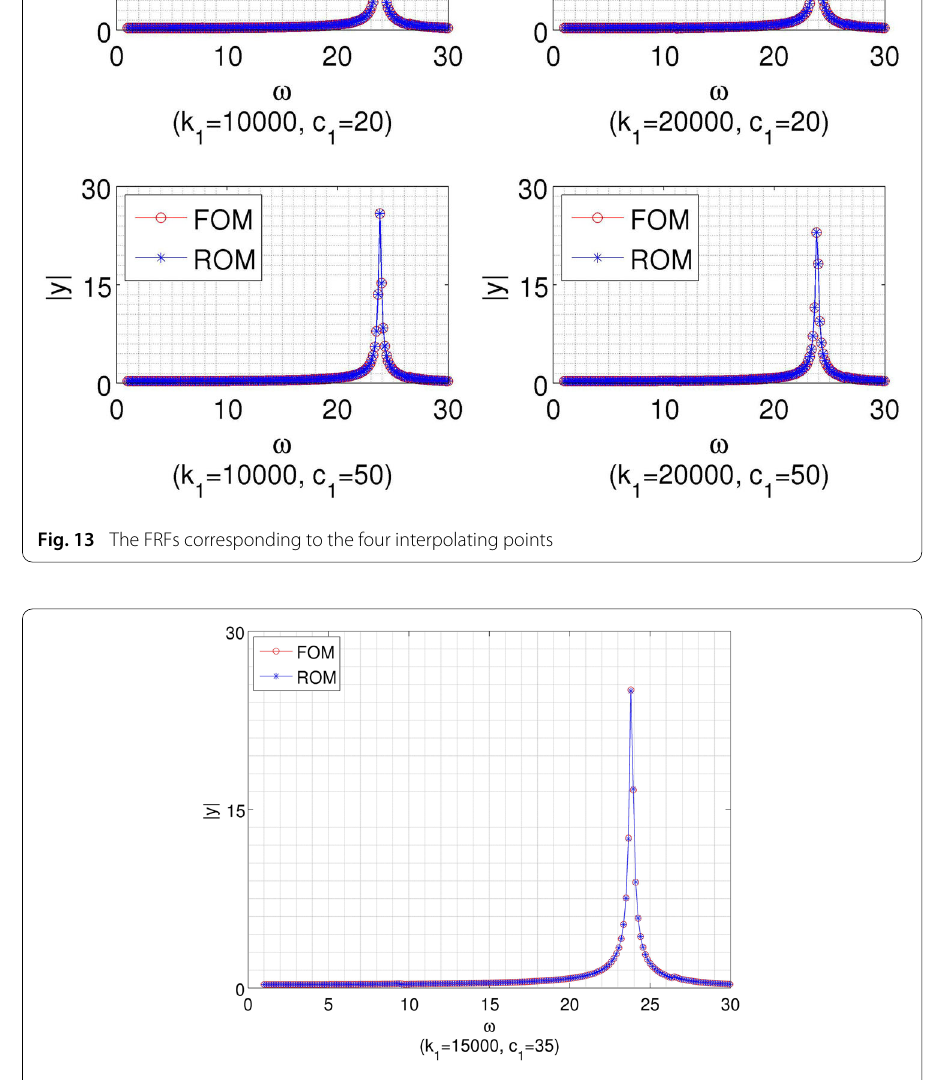
Fig. 14 The FRFs corresponding to the interpolated